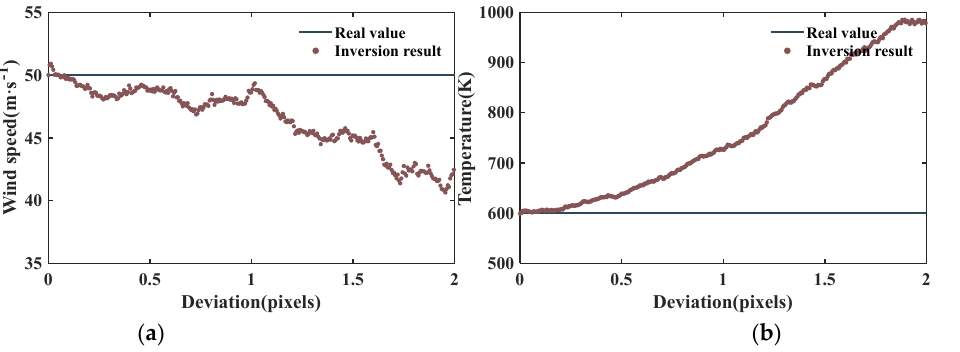
Figure 3. ( a ) Wind and ( b ) temperature versus the deviation between the real center and the center used.